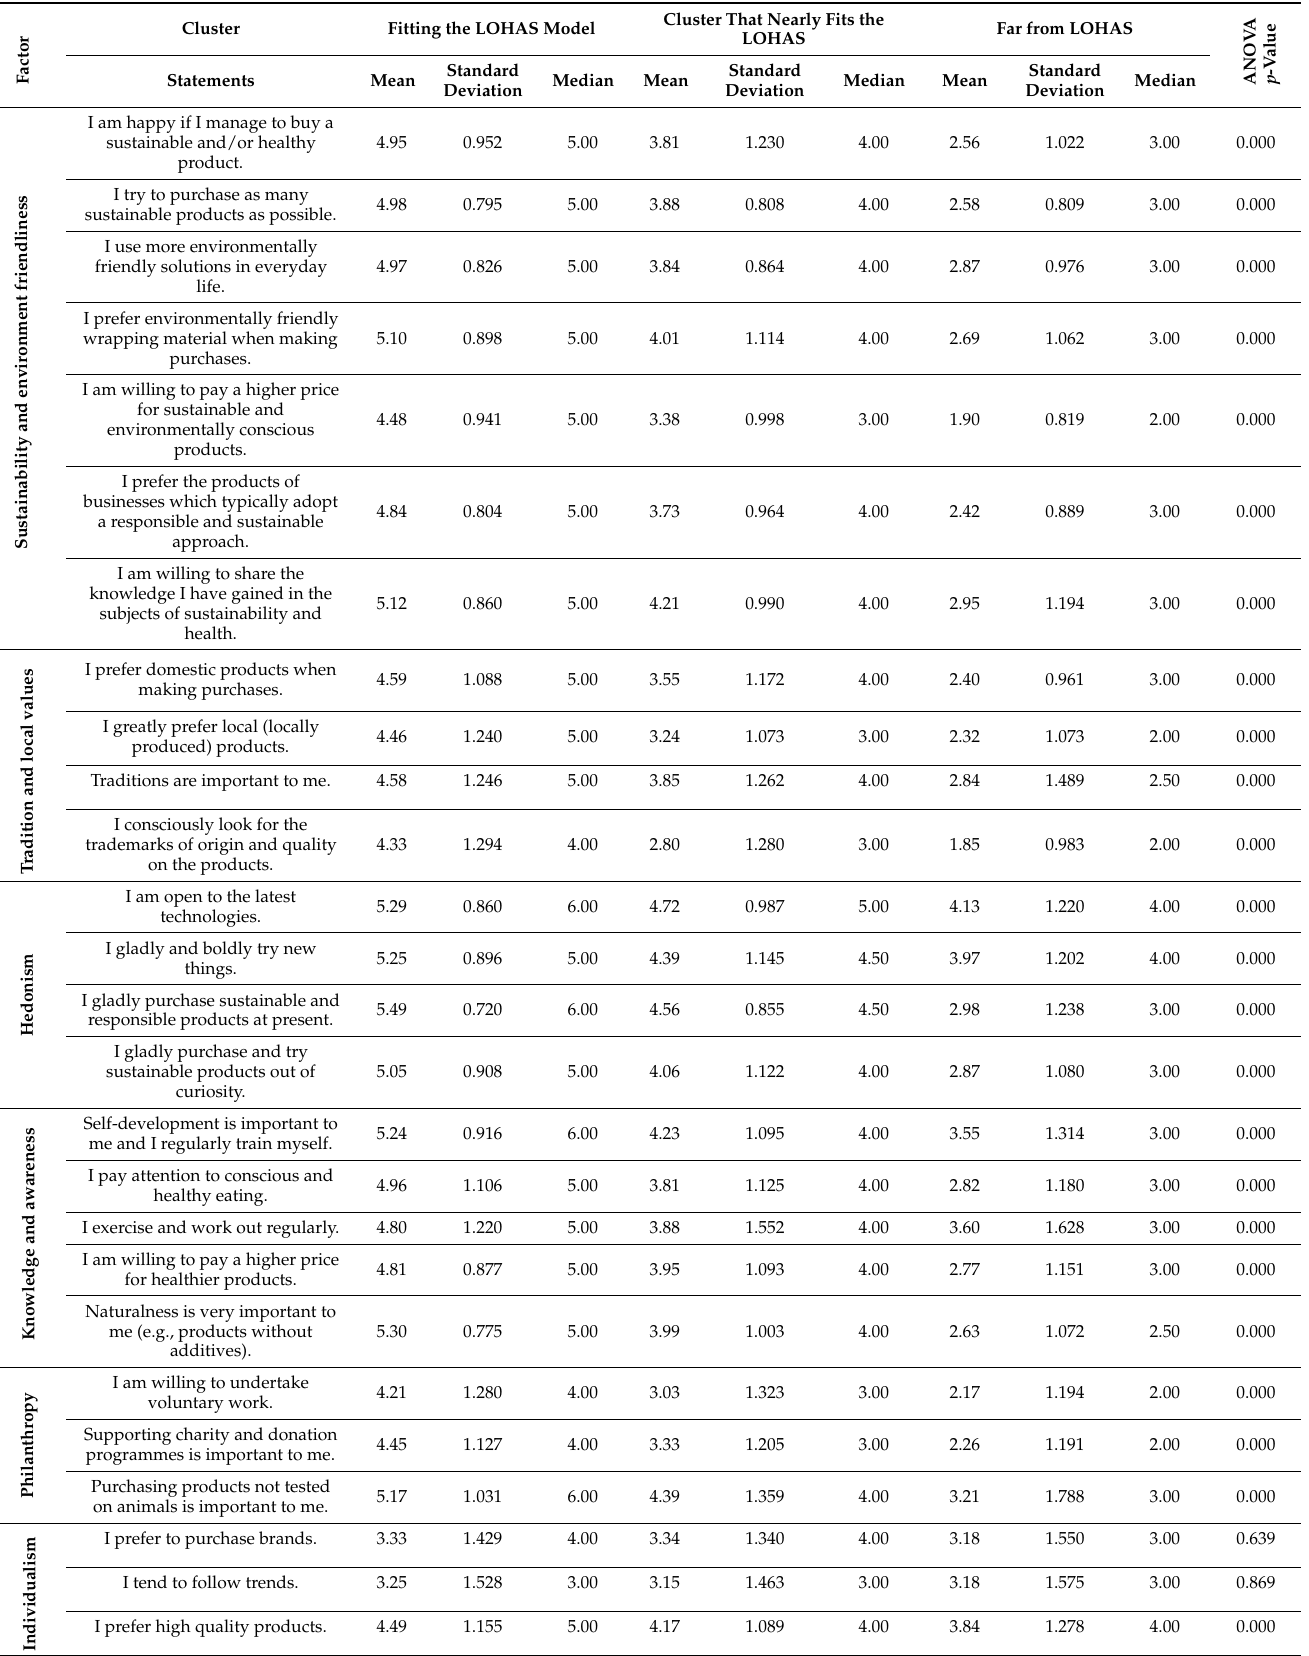
Table 4. Characteristics of the